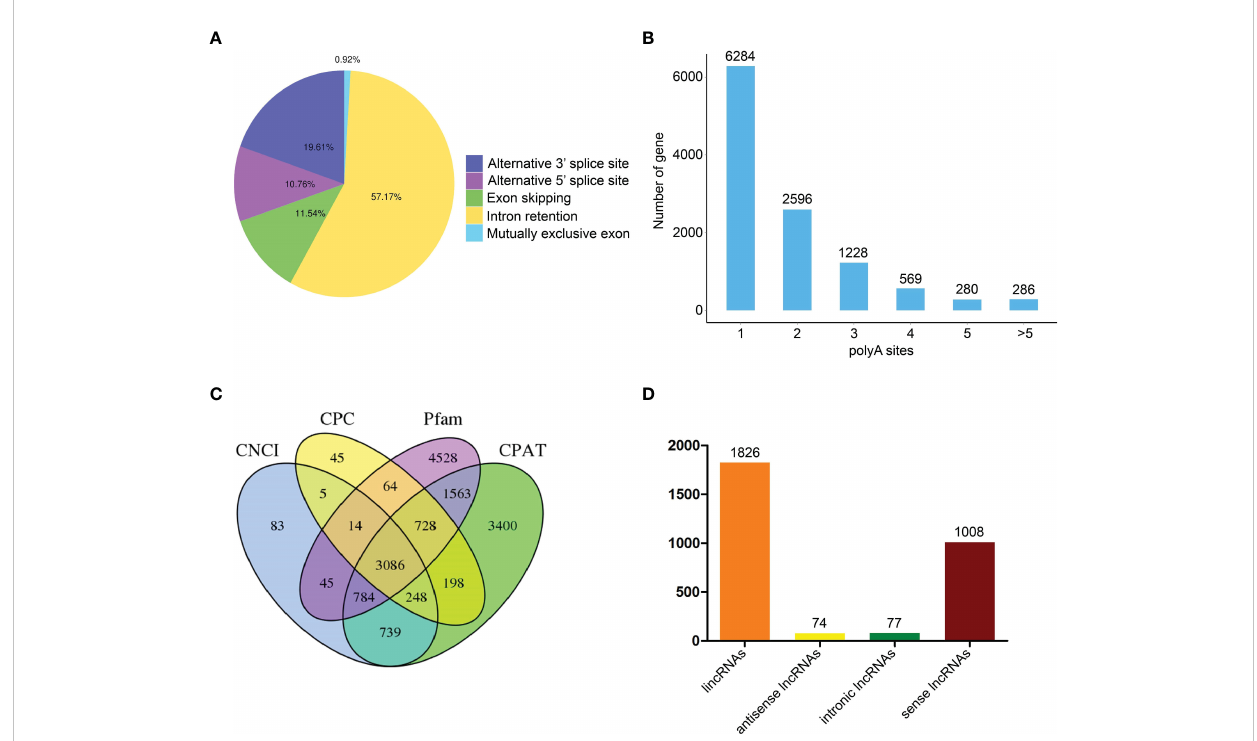
FIGURE 3 Identi fi cation of alternative splicing (AS) events, alternative polyadenylation (APA) and long non-coding RNAs (lncRNAs) based on full-length transcriptome analyses. (A) Number and categories of AS events. (B) Number of genes with different APA sites. (C) Number of lncRNAs based on four analysis methods. (D) Number of various